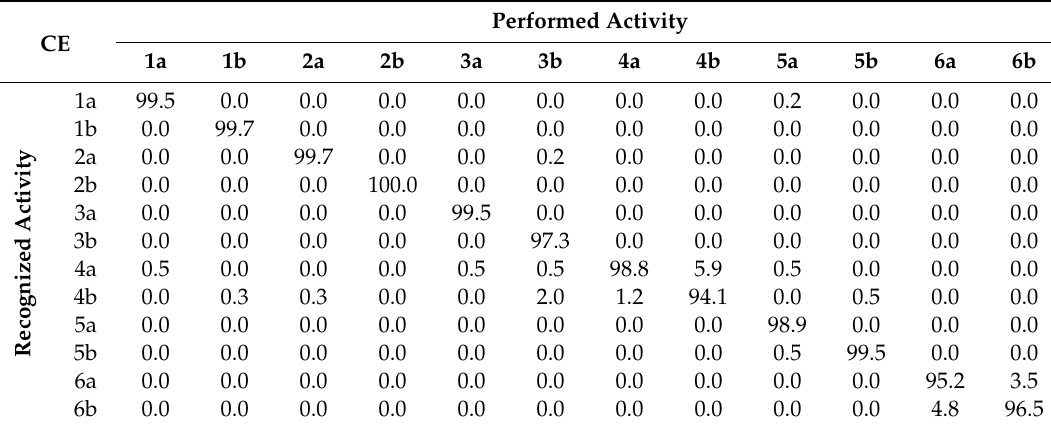
Table A5. Matrix of recognition errors (in %) of 12 motor activities 1a ÷ 6b in test set for all volunteers together for sensor CE.